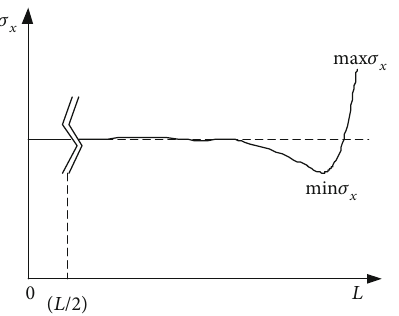
Figure 10: The distribution of the tensile stress on the central axis when the height-diameter ratio L / D is large enough.